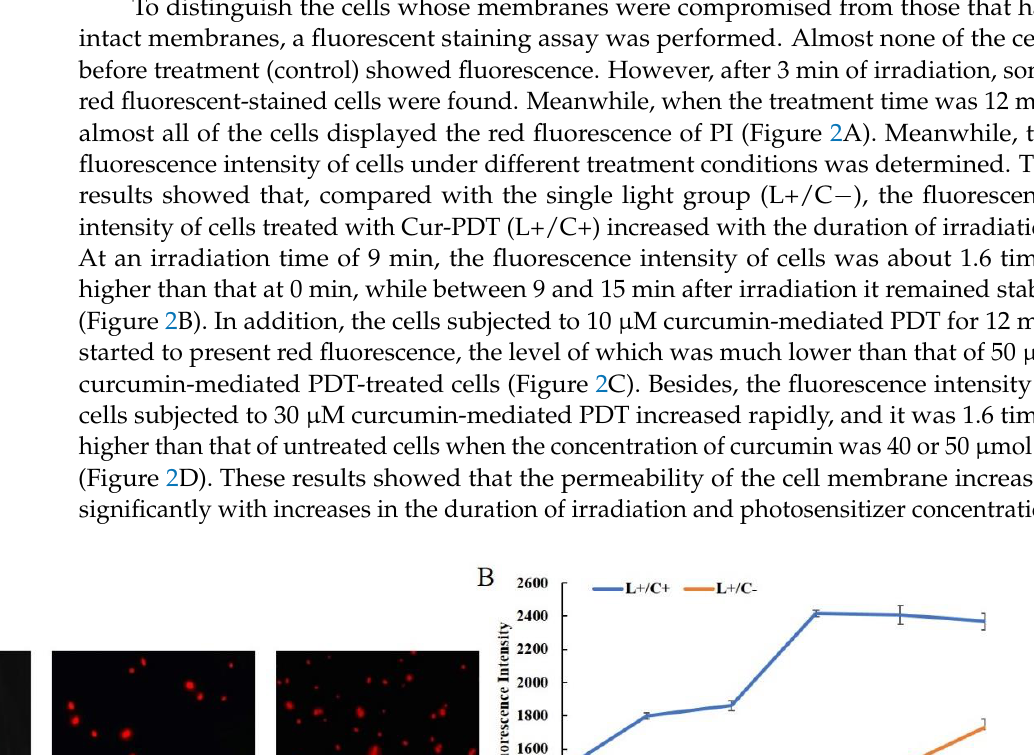
Figure 1. The viability of B. subtilis incubated with the different treatments. ( A ) B. subtilis was treated with 40 μmo l/L curcumin − mediated PDT after the incubation with curcumin for 0, 15, 30, 45, 60, 75 min in the dark. ( B ) B. subtilis was treated 40 μmol/L curcumin − mediated PDT at 0, 30, 60, 90, 120, 150 W after the incubation for 15 min in the dark. ( C ) B. subtilis was treated with 0, 10, 20, 30, 40, 50 umol/L curcumin for 0, 3, 6, 9, 12, 15 min respectively at 120 W after the incubation for 15 min in the dark. Different lowercase letters indicate the significant differences ( p < 0.05).